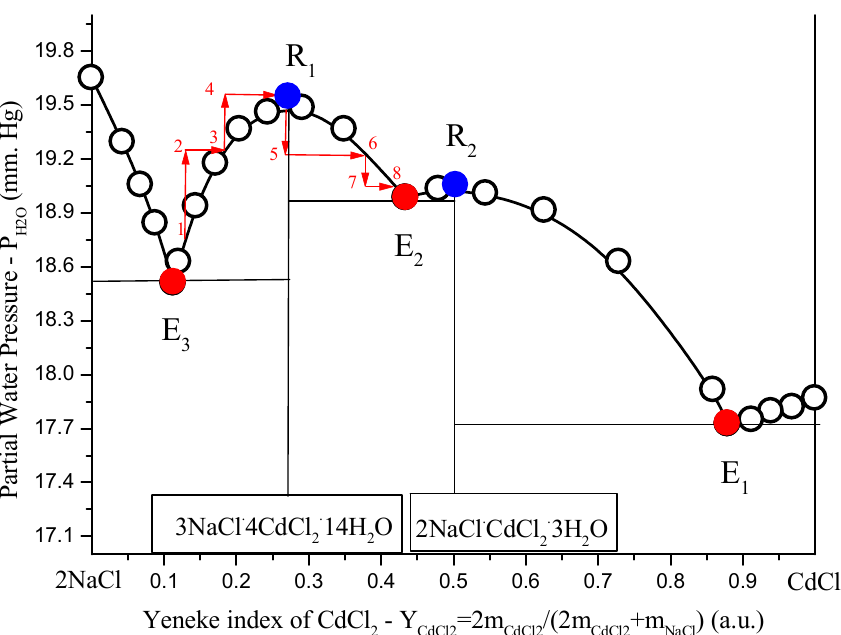
Figure 4. Solubility diagrams in ternary NaCl–CdCl 2 –H 2 O system at 25 ◦ C in the variables: salt Yeneske index H 2 O partial pressure: open black circles, calculation by Extended Pitzer’s Method [14]; red solid circles, non-variant calculated eutonics data ( E i ); blue solid points (R i ) , solubility diagram points type Van Rijn points in fusibility diagrams [17,18]; red arrows show the direction.